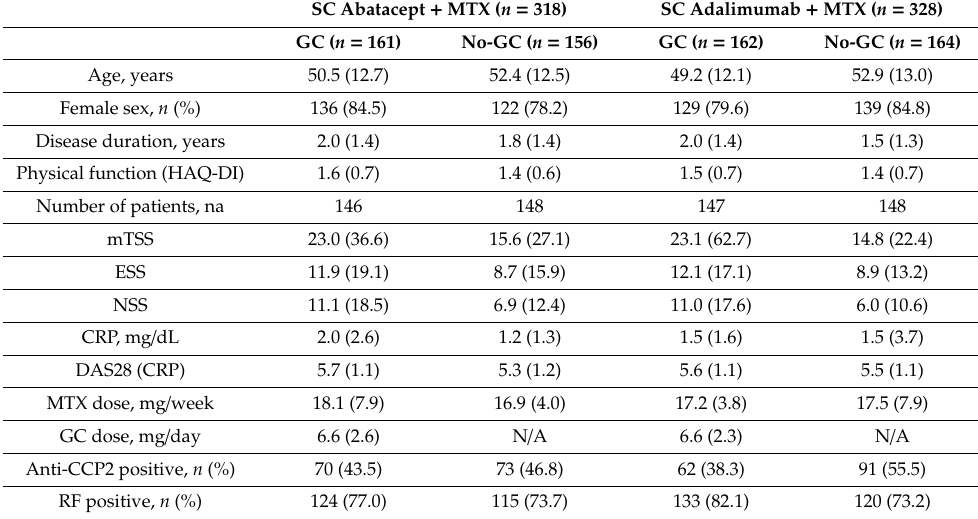
Table 1. Baseline demographics and disease characteristics of